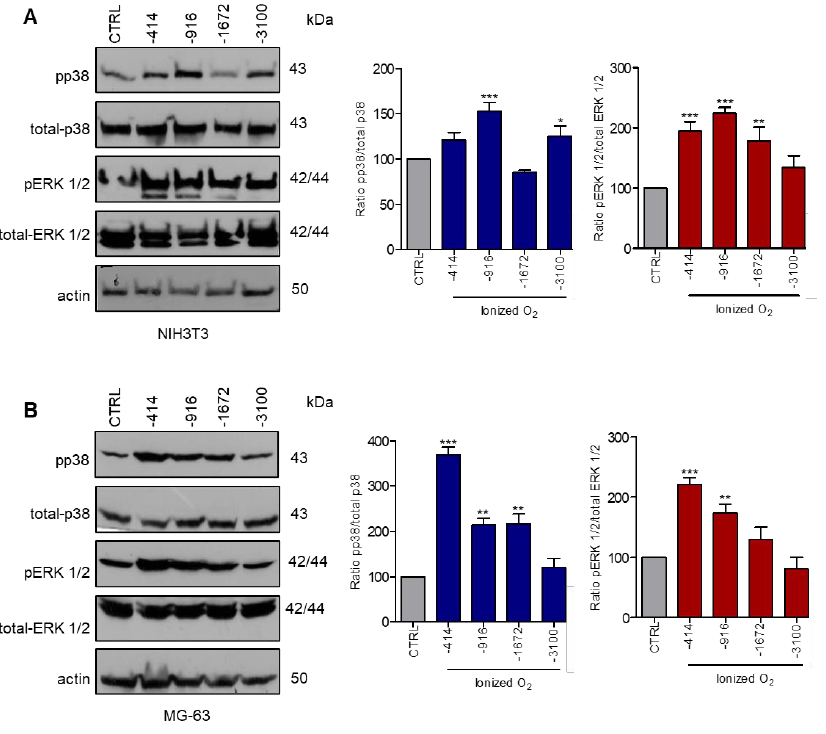
Figure 1. Treatment with microcurrents activates ERK 1/2 and p38 in mouse fibroblasts NIH3T3 and human osteoblast-like MG-63 cells. Total cell lysates from ( A ), NIH3T3 and ( B ), MG-63 cell cultures were separated by SDS-PAGE and immunoblotted to detect the phosphorylation levels of ERK 1/2 and p38. Graphs depict the phosphorylation levels of ERK 1/2 and p38 normalized to total-ERK 1/2 and total p38, respectively. Actin was used as the loading control. (* p < 0.05, ** p < 0.01, *** p < 0.005, treated vs. control, n = 3).